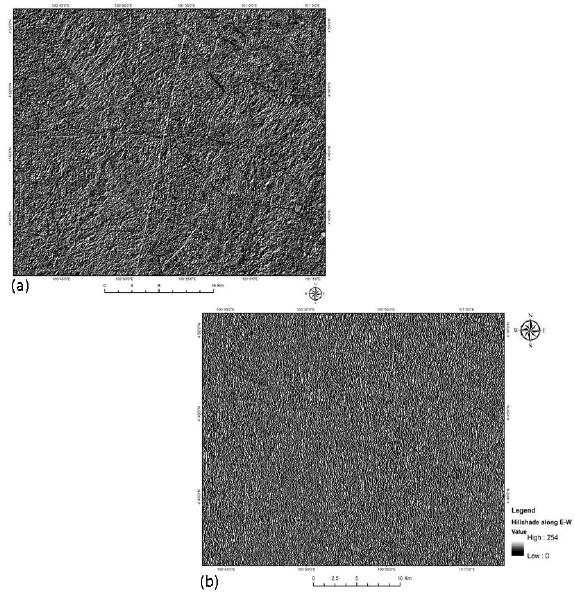
Figure 4: Satellite image Lineament acquired by directional filter, (a) lineaments oriented NE–SW with a trace of the Highway indicated (b) Hillshade along